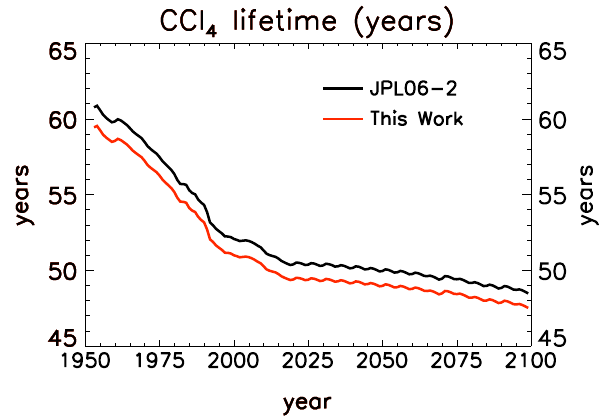
Fig. 7. Time series for 1950–2100 of the modeled photochemical lifetime of CCl 4 (years) using the UV absorption cross sections ob- tained in this work (red), and absorption cross sections from JPL06- 2 (Sander et al., 2006) (black). Note that the calculation of lifetime does not include any surface land or ocean loss of CCl 4